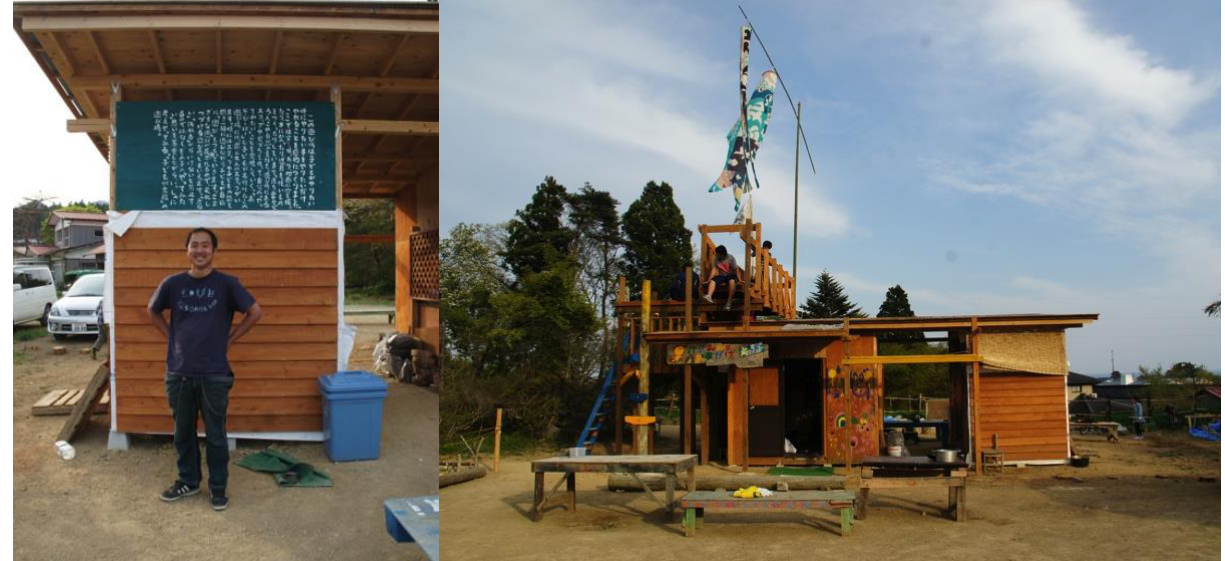
Figure 1. Adventure playground Asobi-ba in Kesenuma, playworker Kanpei